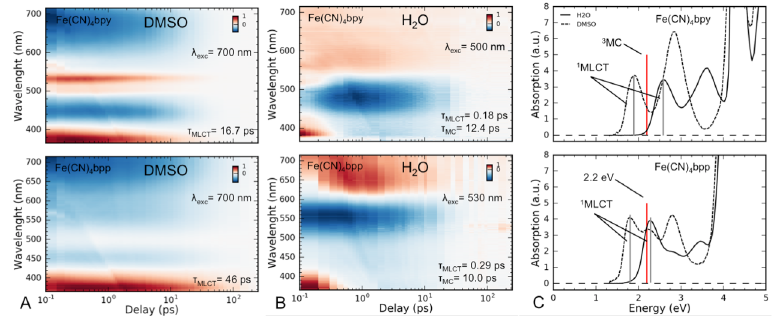
Fig. 2. Femtosecond transient absorption data of [Fe(CN) 4 (bpy,bpp)] 2- in (A) DMSO and (B) H 2 O. First row depicts data of [Fe(CN) 4 (bpy)] 2- and second row data of [Fe(CN) 4 (bpp)] 2- . Negative ground state (GS) spectra are scaled for better comparison. (C) Solvatochromism of the UV/vis aborption spectra and the energies of low energy metal-centred